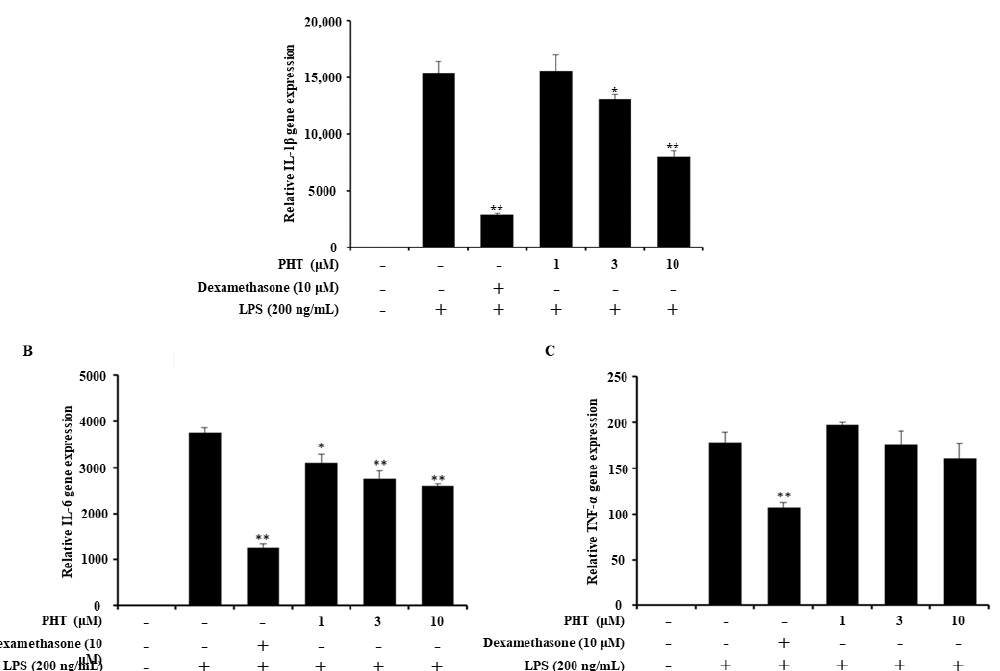
Figure 2. Effect of PHT on LPS-induced proinflammatory gene expression. J774 cells were seeded and pretreated with 10 μM dexamethasone or 1, 3, or 10 μM PHT for 1 h before LPS (200 ng/mL) treatment for 12 h. Total RNA was extracted and used to synthesize cDNA. ( A ) IL-1β, ( B ) IL-6 and ( C ) TNF-α gene expression were measured by quantitative real-time PCR. The gene expression level was normalized to GAPDH expression and is presented as the fold change relative to the untreated group. The values are presented as the mean ± SD of three individual experiments. * p < 0.05, ** p < 0.01 compared with the LPS-alone group.